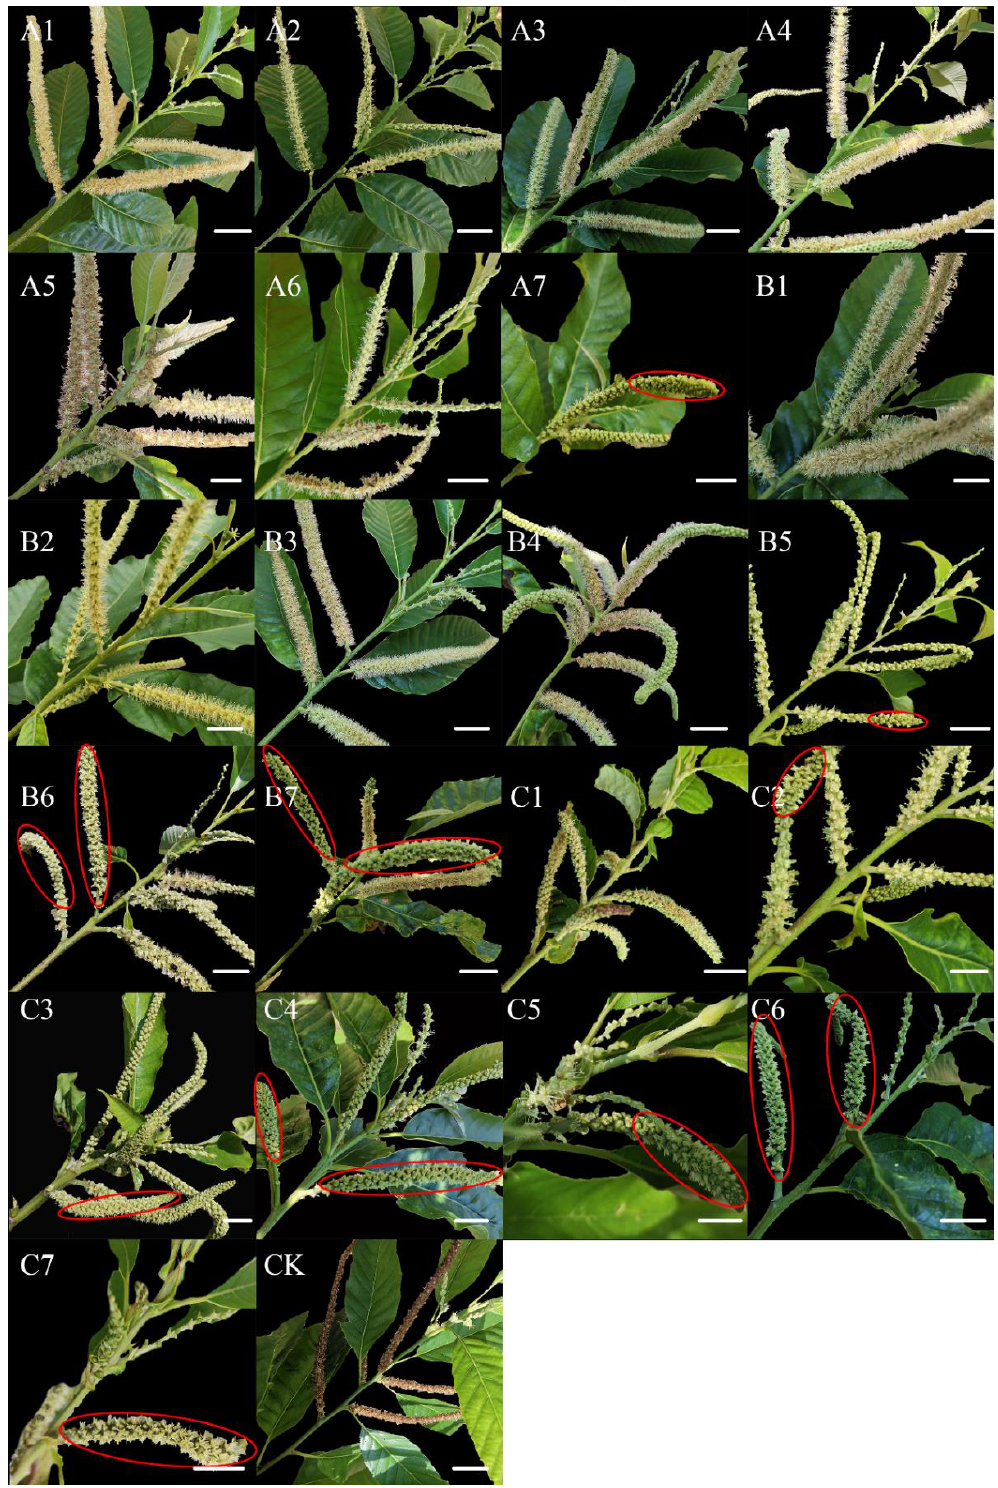
Figure 2. The male catkin of Casatanea henryi under different treatments. A1 – C7 represent different treatment methods. CK is the control group of pure water treatment. The female flowers are circled in red. All scale bars = 10 mm.